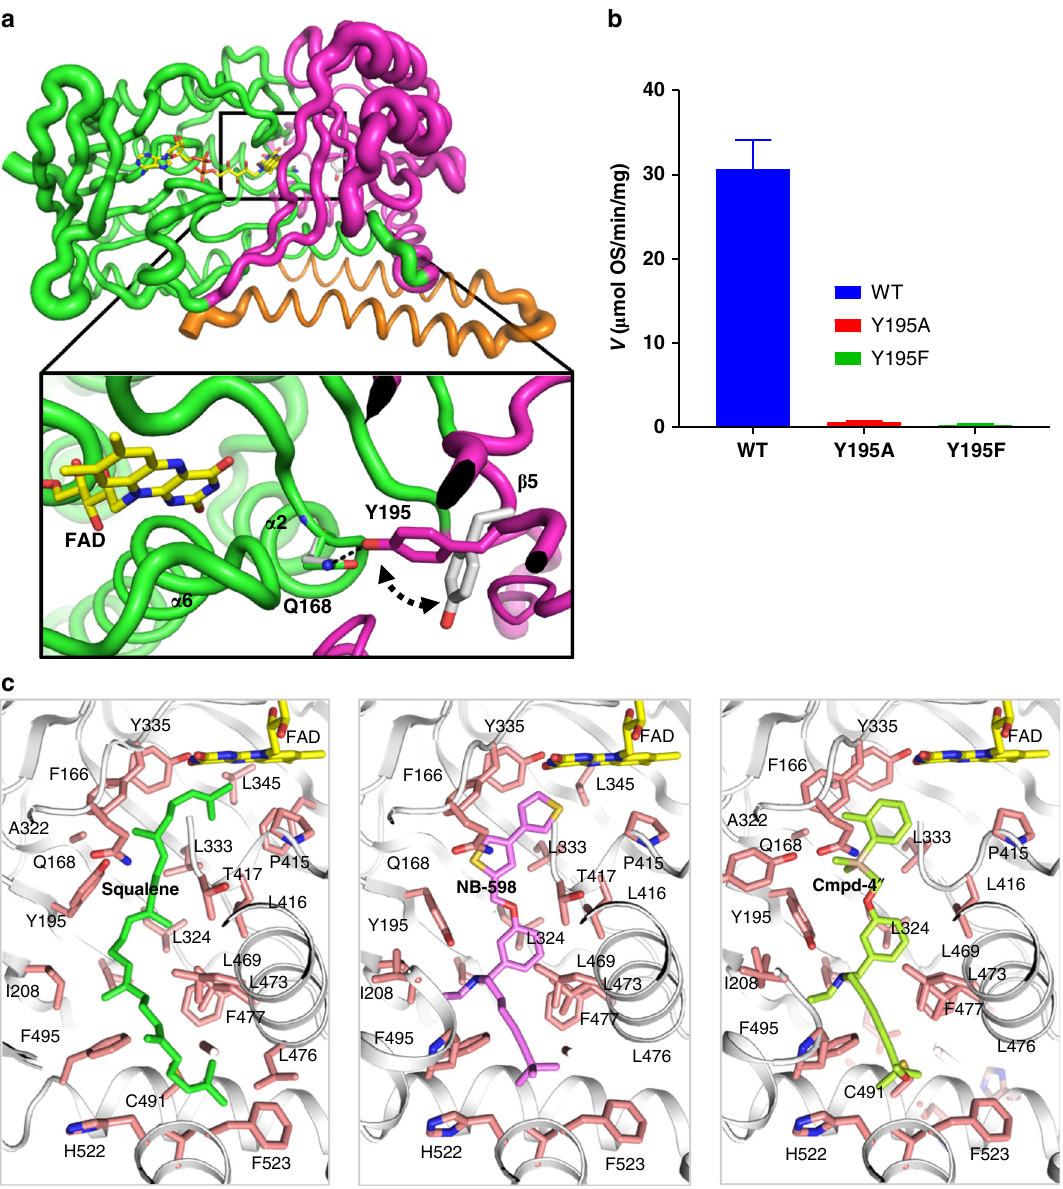
Fig. 5 SQLE conformational rearrangements and the role of Y195. a Domain rearrangements in the unliganded SQLE structure in comparison with inhibitor- bound structure. Overall structure is shown in putty tube representation with the scaling to re fl ect the RMSD value calculated between SQLE (cid:129) FAD and SQLE (cid:129) FAD (cid:129) Cmpd-4 ′′ structures. FAD-binding domain in green, the substrate-binding domain in magenta, and the C-terminal membrane – associated helical domain in orange. FAD is in stick presentation with carbon atoms in yellow. A relatively higher degree of changes is observed for substrate-binding domain in comparison with other domains. The conformational change for Y195 between SQLE (cid:129) FAD (in magenta) and SQLE (cid:129) FAD (cid:129) Cmpd-4 ′′ (in gray) is illustrated in the inset with dashed black arrows. The hydrogen bond between Y195-Q168 in the unliganded SQLE (cid:129) FAD structure is indicated by black dashed line. b Y195 mutants abrogate SQLE speci fi c activity. SQLE enzymatic activity was assessed using the baculosome overexpression system. Bars represent the mean and standard deviation of triplicate measurements. c Side by side comparison of substrate-bound model of SQLE (right) with SQLE (cid:129) FAD (cid:129) NB-598 (center) and SQLE (cid:129) FAD (cid:129) Cmpd-4 ′′ (left) structures. Squalene was docked into the long extended non-polar pocket of the unliganded structure within the substrate-binding domain. Side chains of amino acids in the binding site (light pink), FAD (yellow), squalene (green), NB-598 (pink), and Cmpd-4 ′′ (light green) molecules are in stick representation and shown in the same relative